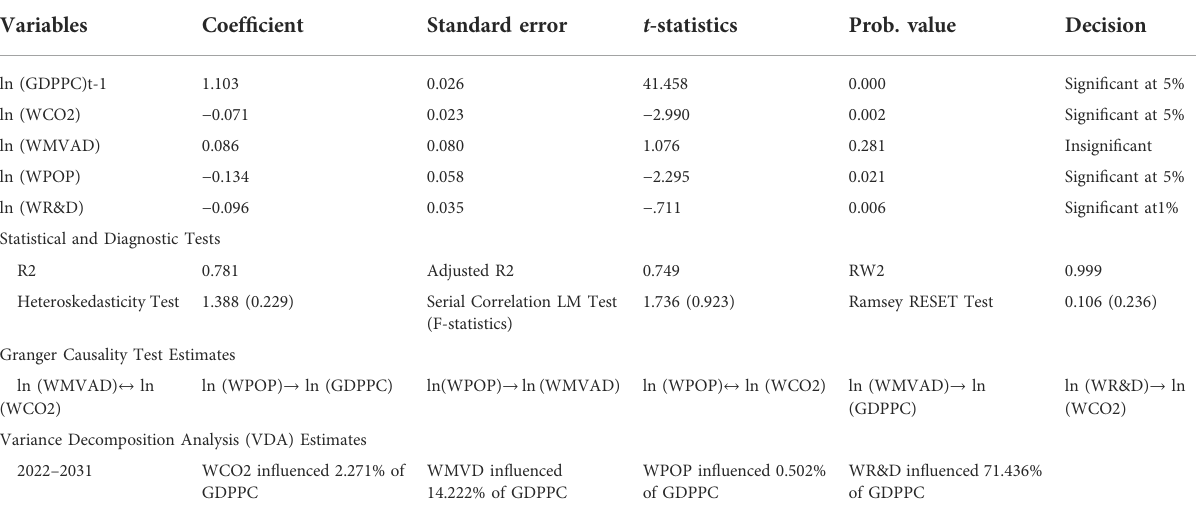
TABLE 1 RLS estimates, granger causality and VDA